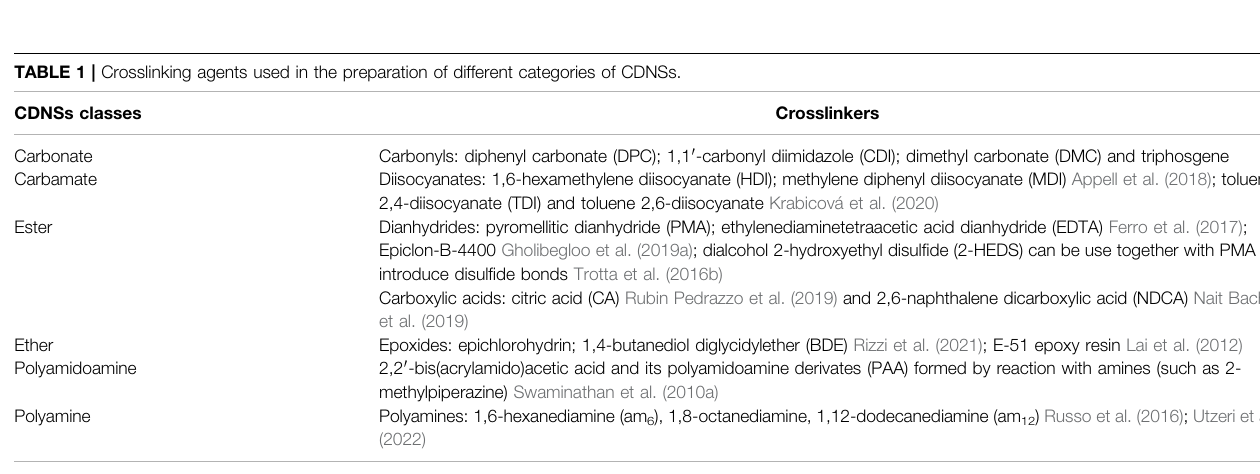
FIGURE 2 | Schematic representation of CDNSs main applications and their advantages.